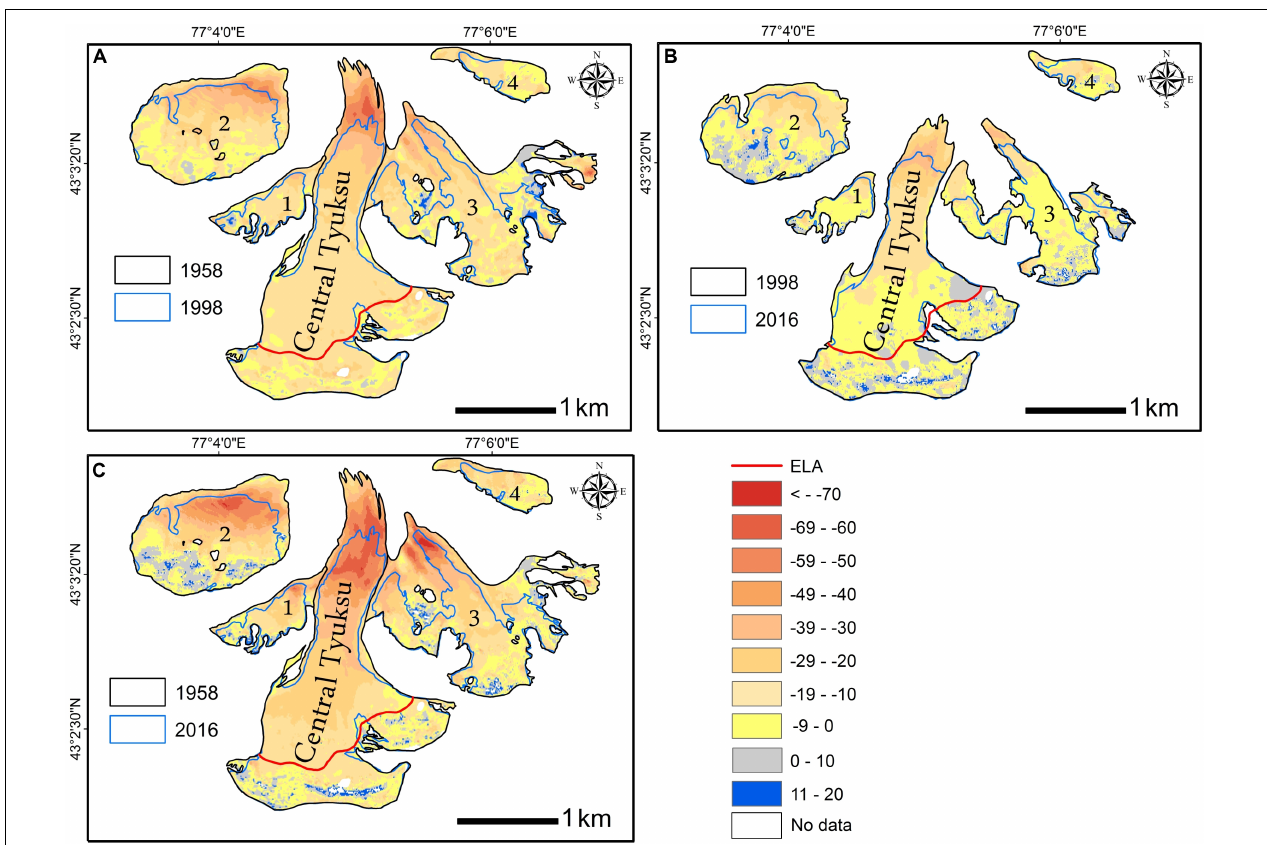
FIGURE 6 | Changes in the surface elevation of glaciers of the Tuyuksu group (m): (A) 1958–1998; (B) 1998–2016; (C) 1958–2016. (1) Kosmodemjanskaya; (2) Molodezhniy; (3) Igly Tuyuksu; and (4) Ordzhonikidze.